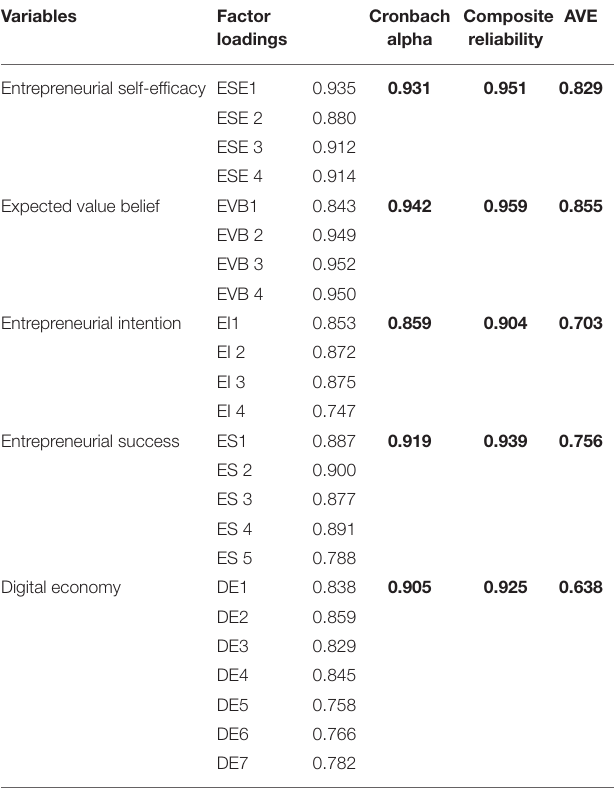
TABLE 2 | Reliabilities and validities of the scale. Variables